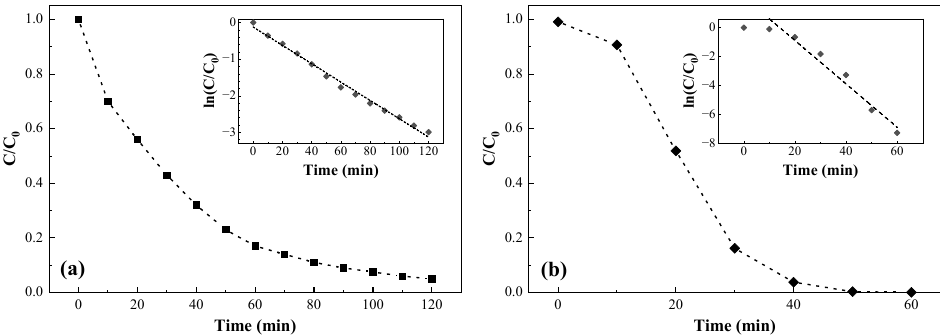
Figure 4. Photocatalytic activity for ( a ) RhB degradation and ( b ) U(VI) reduction with g-C 3 N 4 -MA- COS NCs at pH 6 under visible light irradiation.